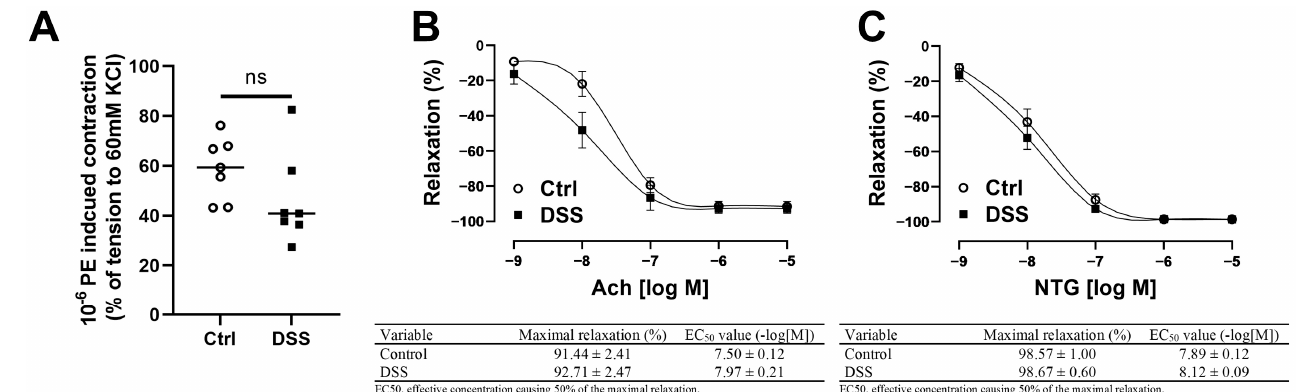
Figure 4. Femoral artery contractility and endothelial function were preserved in the chronic colitis model. ( A ) PE-induced contractility of femoral artery. ( B ) Ach-induced endothelium-dependent relaxation of femoral artery, maximal relaxation and EC50 for Ach were calculated in the table. ( C ) NTG-induced endothelium-independent relaxation of femoral artery, maximal relaxation and EC50 for NTG were calculated in the table. Results are expressed as mean ± SEM. By unpaired 2-tailed Student’s t -test ( A ), in two-way ANOVA followed by Bonferroni correction( B , C ), n = 7 mice in each group. PE, phenylephrine; Ach, acetylcholine; NTG, nitroglycerin.